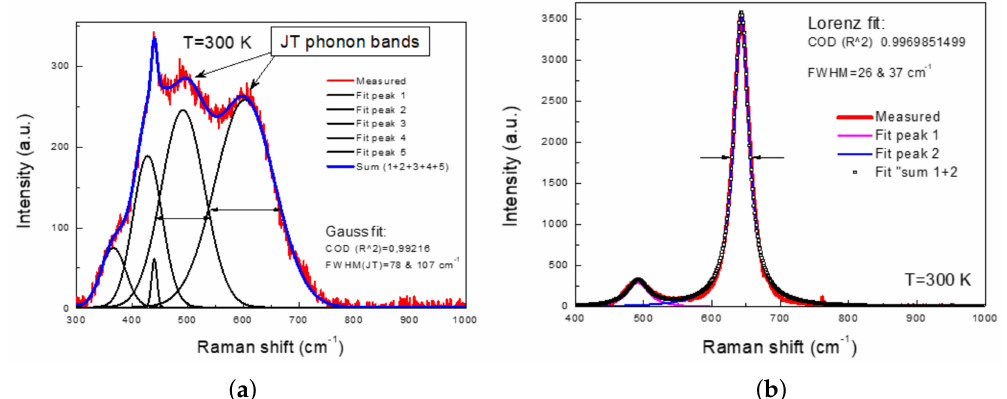
Figure 3. Ramanspectraofatypicalcolossalmagnetoresistance(CMR)manganite(La 1 − y Pr y ) 0.7 Ca 0.3 MnO 3 film ( a ) and of a B-site ordered double perovskite film La 2 CoMnO 6 ; and ( b ) measured at room temperature by using a second harmonic of Nd:YAG laser excitation with λ = 532